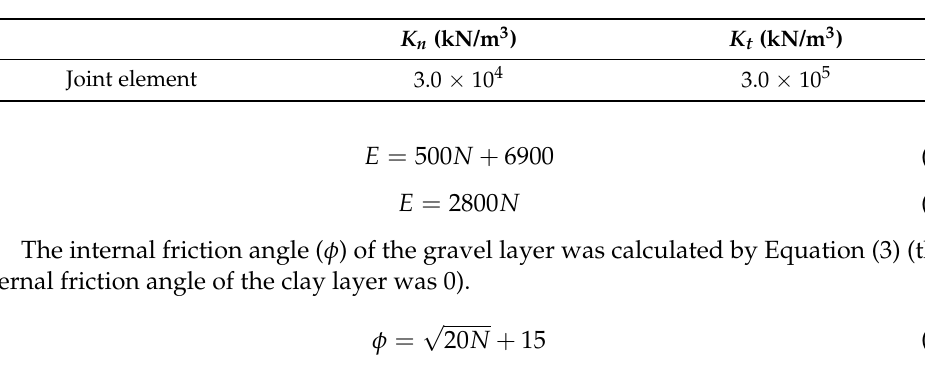
Table 3. Parameters of the joint element used for the